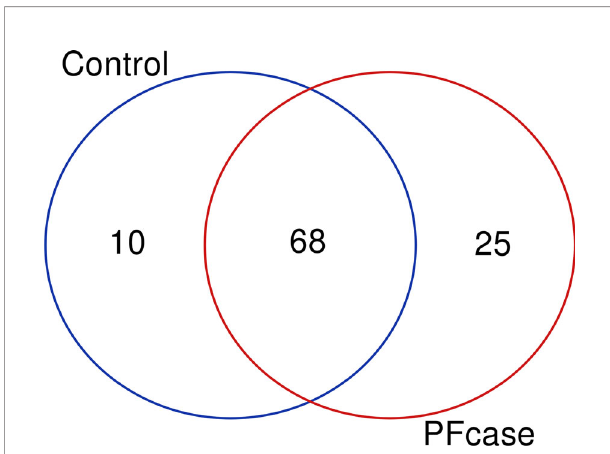
FIGURE 3 | Venn diagram illustrating overlap and number of unique taxa between controls and PFcases. The red and green circles represent PFcases and controls respectively.